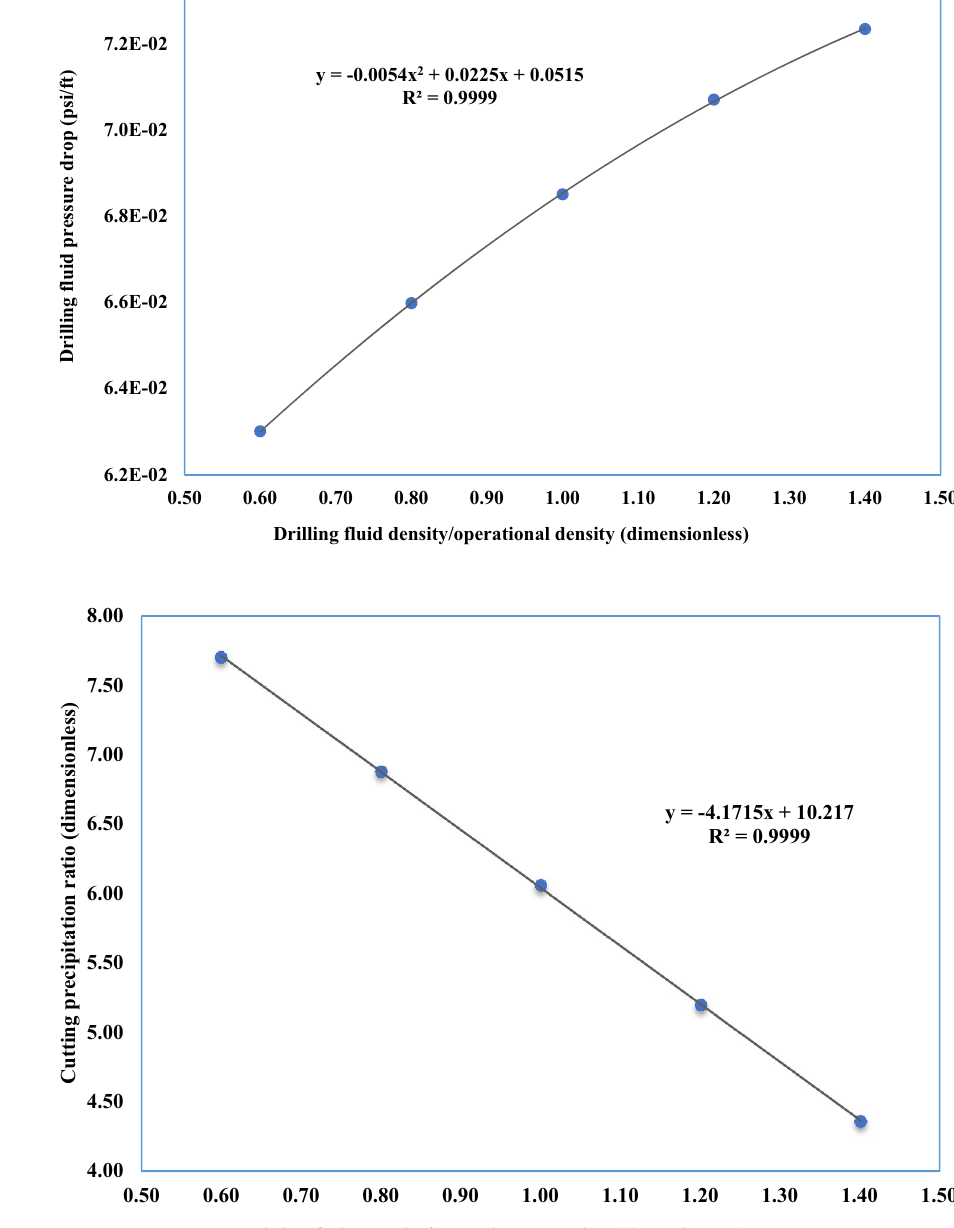
Fig. 16 Pressure drop of the fluid in the annulus versus drill- ing mud density